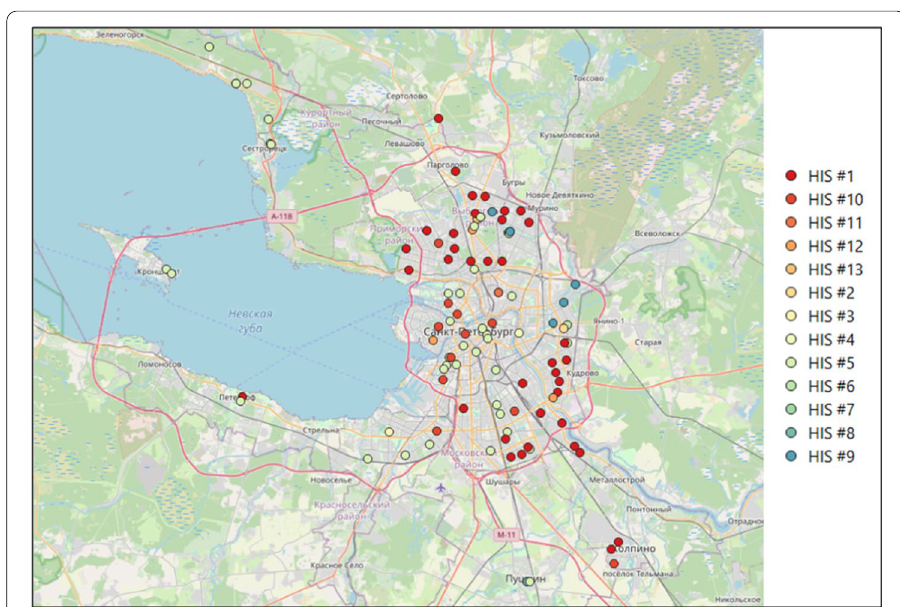
Fig. 1 Distribution of EHR providers (healthcare organizations) in Saint Petersburg with different